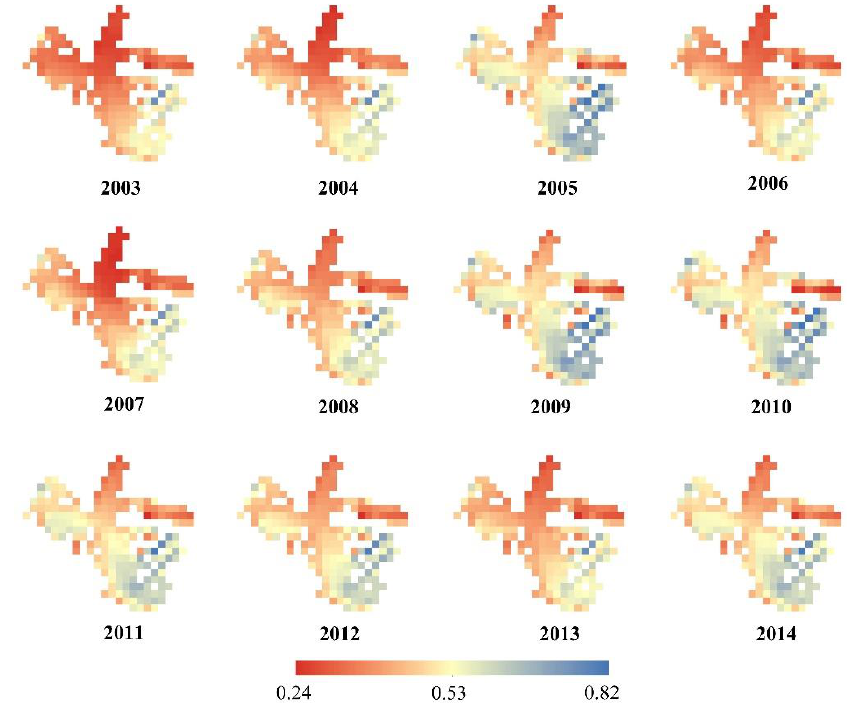
Figure 3. Spatial distributions for the average summer albedo maps retrieved using MODImLab for the Chhota Shigri glacier from 2003 to 2014. Grids in the maps are the MODImLab albedo results with 250 m